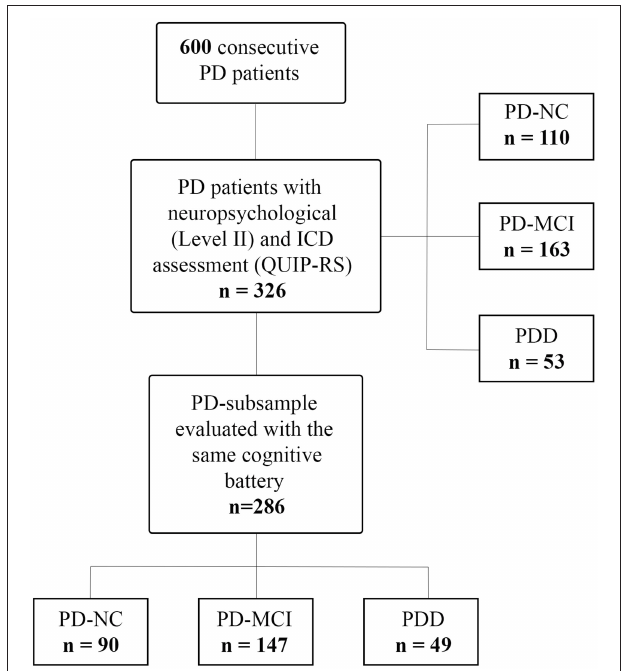
FIGURE 1 | Study flowchart. PD, Parkinson’s disease; PD-NC, PD with normal cognition; PD-MCI, PD with mild cognitive impairment; PDD, PD with dementia; ICD, impulse control disorder; QUIP-RS, Questionnaire for Impulsive-Compulsive Disorders in Parkinson’s Disease-Rating